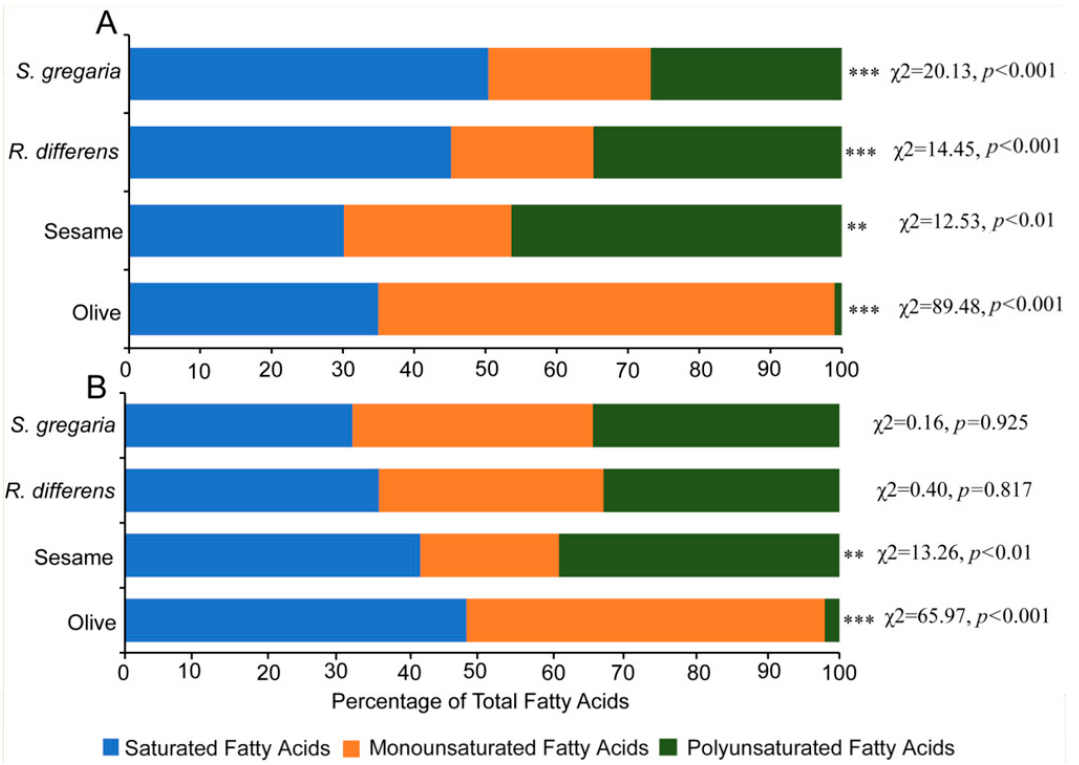
Figure 5. Fatty acid methyl esters (FAMEs) composition in different plants, insect oils and cookies prepared from the same oils. ( A ). FAMEs in plant and insect oils. ( B ). FAMEs in cookies prepared from the plant and insect oils. * Denotes significantly different at 0.05. ** Denotes significantly di ff erent at 0.01. *** Denotes significantly di ff erent at